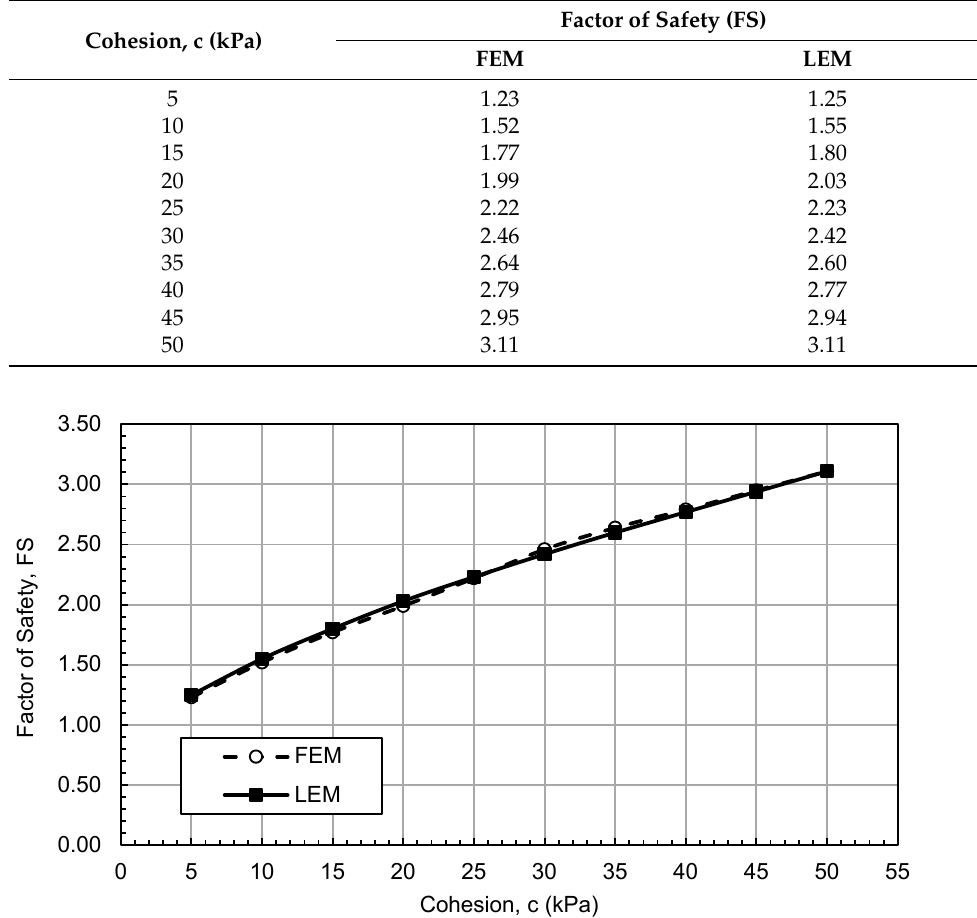
Table 2. Analysis results for different cohesion values.